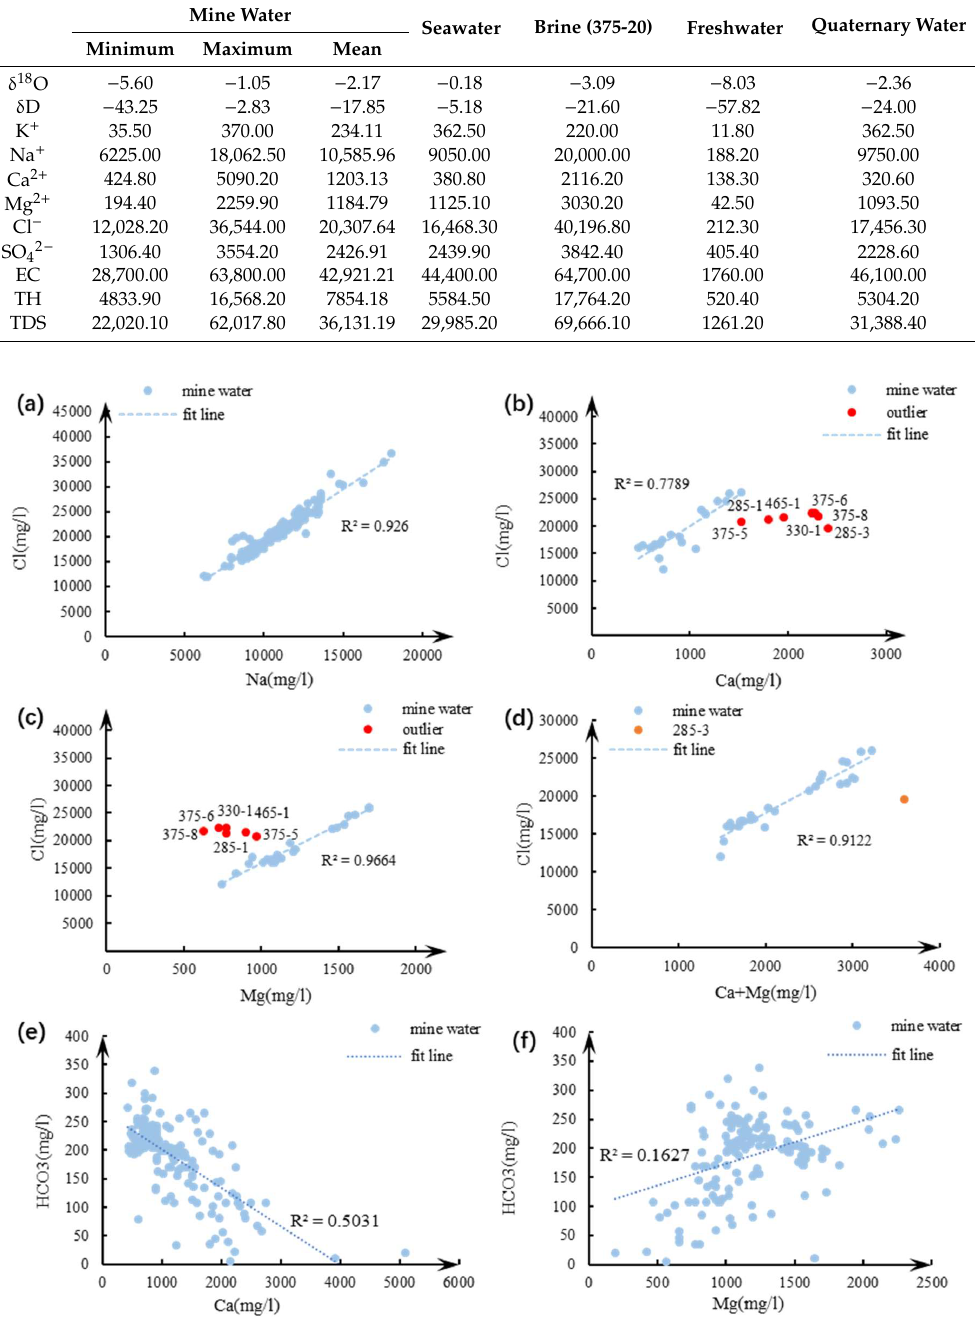
Figure 4. Correlation of ions. ( a ) Na vs. Cl, ( b ) Ca vs. Cl, ( c ) Mg vs. Cl, ( d ) Ca + Mg vs. Cl, ( e ) Ca vs. HCO 3 , and ( f ) Mg vs HCO 3 .